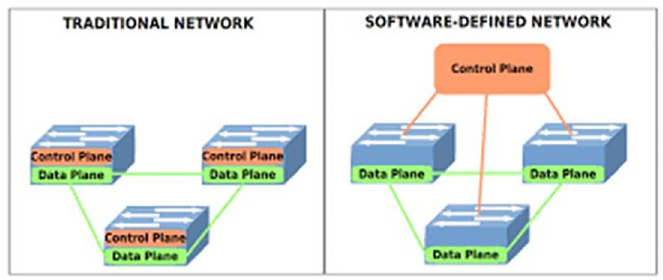
Fig 1. Traditional versus SDN network